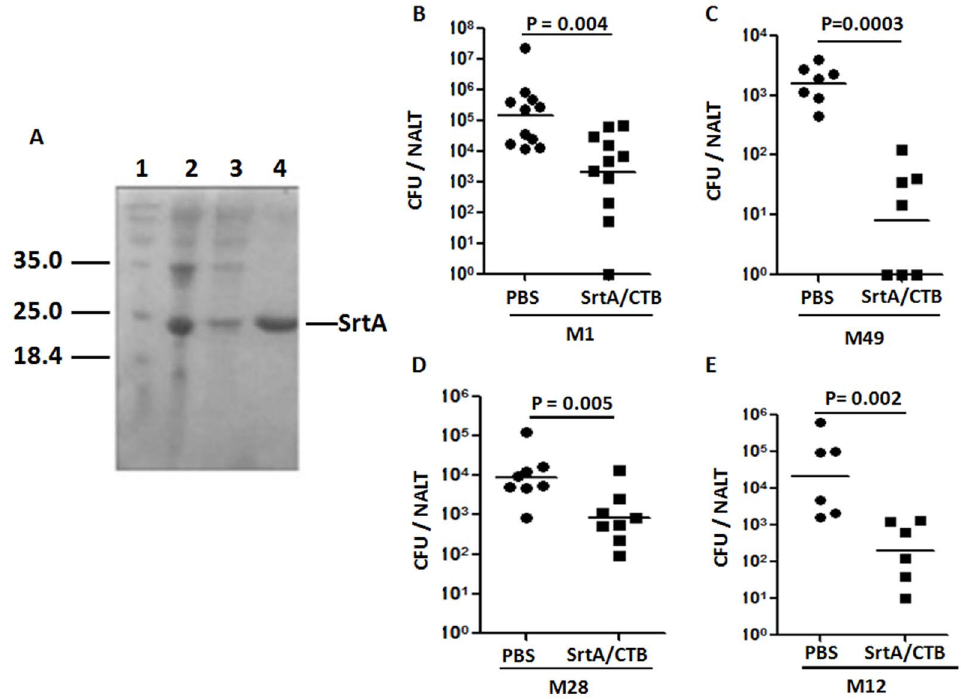
Figure 2. Immunization (i.n.) with SrtA/CTB promoted cross-serotype clearance of GAS. Recombinant SrtA protein in sonicated BL21 cells was purified by affinity chromatography on NiOS 2 -charged chelating Sepharose Fast Flow gel and analyzed by SDS-PAGE ( A ). 1. Molecular weight; 2. Whole cell lysate loaded on the column; 3. Unbound; 4. Eluted protein. Mice were i.n. immunized with SrtA and CTB three times. 10 days after the last immunization mice were challenged with a sublethal dose of live GAS serotypes M1 ( B ), M49 ( C ), M28 ( D ) or M12 ( E ). NALTs were taken 24 hr after challenge and homogenized for CFU counting. Data are geometric means of two to three independent experiments.